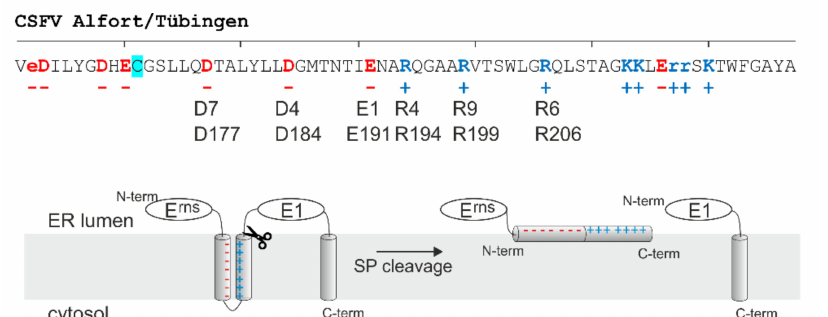
Figure 3. Scheme presenting the E rns charge zipper hypothesis. The upper part shows the carboxy- terminal amino acid sequence of E rns (sequence CSFV Alfort/Tübingen). Charged residues are shown in red (negative charge, indicated also by “-“) or blue (positive charge, indicated also by “+”). Cysteine 171, which is responsible for E rns homodimerization, is highlighted with a turquoise background. Above the amino acid sequence, a scale with 10-residue calibration starting with glutamic acid at Position 170 is shown. Below the amino acid sequence, the net charges of the residues are given. The designations of the amino acids mutated in the studies presented here are given with the short forms used especially in the figures and the full number as used in the text: D7 = Asp177, D4 = Asp184, E1 = Glu191, R4 = Arg194, R9 = Arg199, and R6 = Arg206. The bottom part shows a scheme summarizing the charge zipper theory proposed to be involved in processing the E rns -E1 precursor. The charge zipper allows the initial formation of a hairpin structure inserted into the membrane, thereby forming a suitable substrate for SP cleavage. After processing, the E rns carboxy-terminus is proposed to re-orientate and form an amphipathic helix binding in plane to the membrane surface as experimentally determined for the mature protein [16]. The scheme was based on the original presentation of the hypothesis [78] but modified according to recently published data on the role of E1 for the processing step